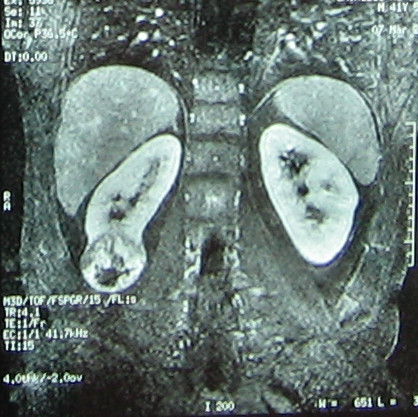
Preoperative MRI. MRI showing a solid right lower pole mass, well circumscribed with inhomogeneous internal structure.